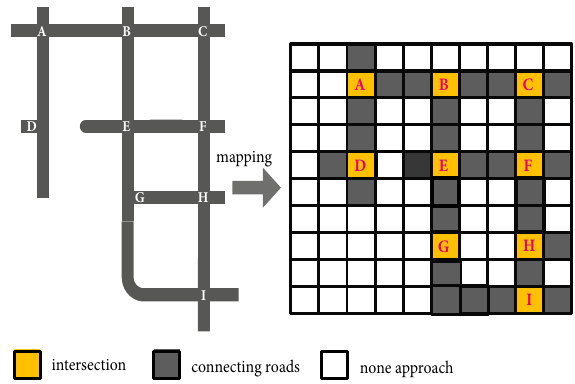
Fig. 1. The mapping between multi-intersections and virtual